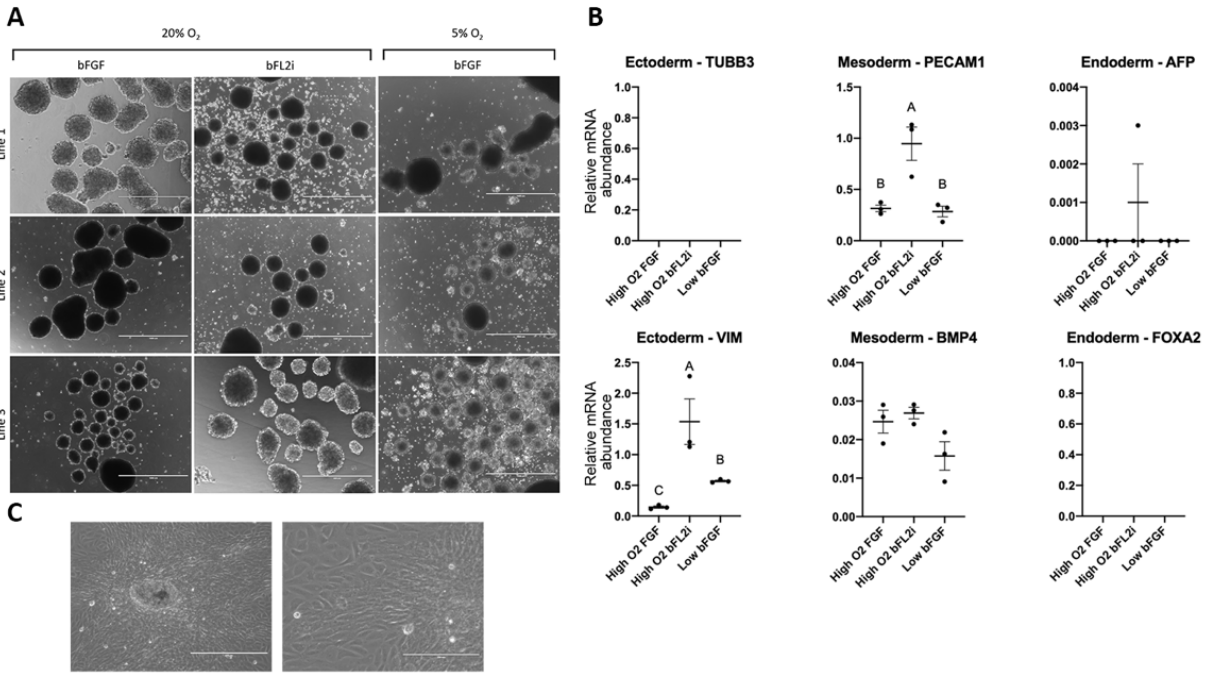
Figure 3. Morphological and gene expression analyses of the embryoid bodies ( A ) and derived culture after EBs dissotiation and undirected differentiation ( B , C ). ( A ). All biPSC lines were able to be differenciated in EBs after 5 days in supension culture. ( B ) An analysis of the gene expression showed the genes VIM, PECAM1 BMP4 and AFP; however, TUBB3 and FOXA were observed. Statistical differences are presented by different letters ( p < 0.05). ( C ) The EBs were able to adhere to the plate and were differentiated into morphologically different cellular types. Scale bars: 400 and 200 μ m.